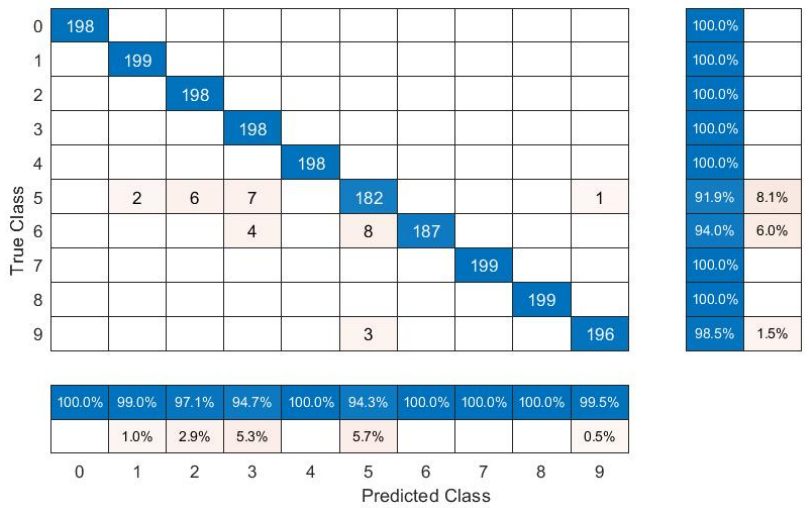
Figure 14. Confusion chart for the proposed method: training performed under OC-3 and tested under OC-4.